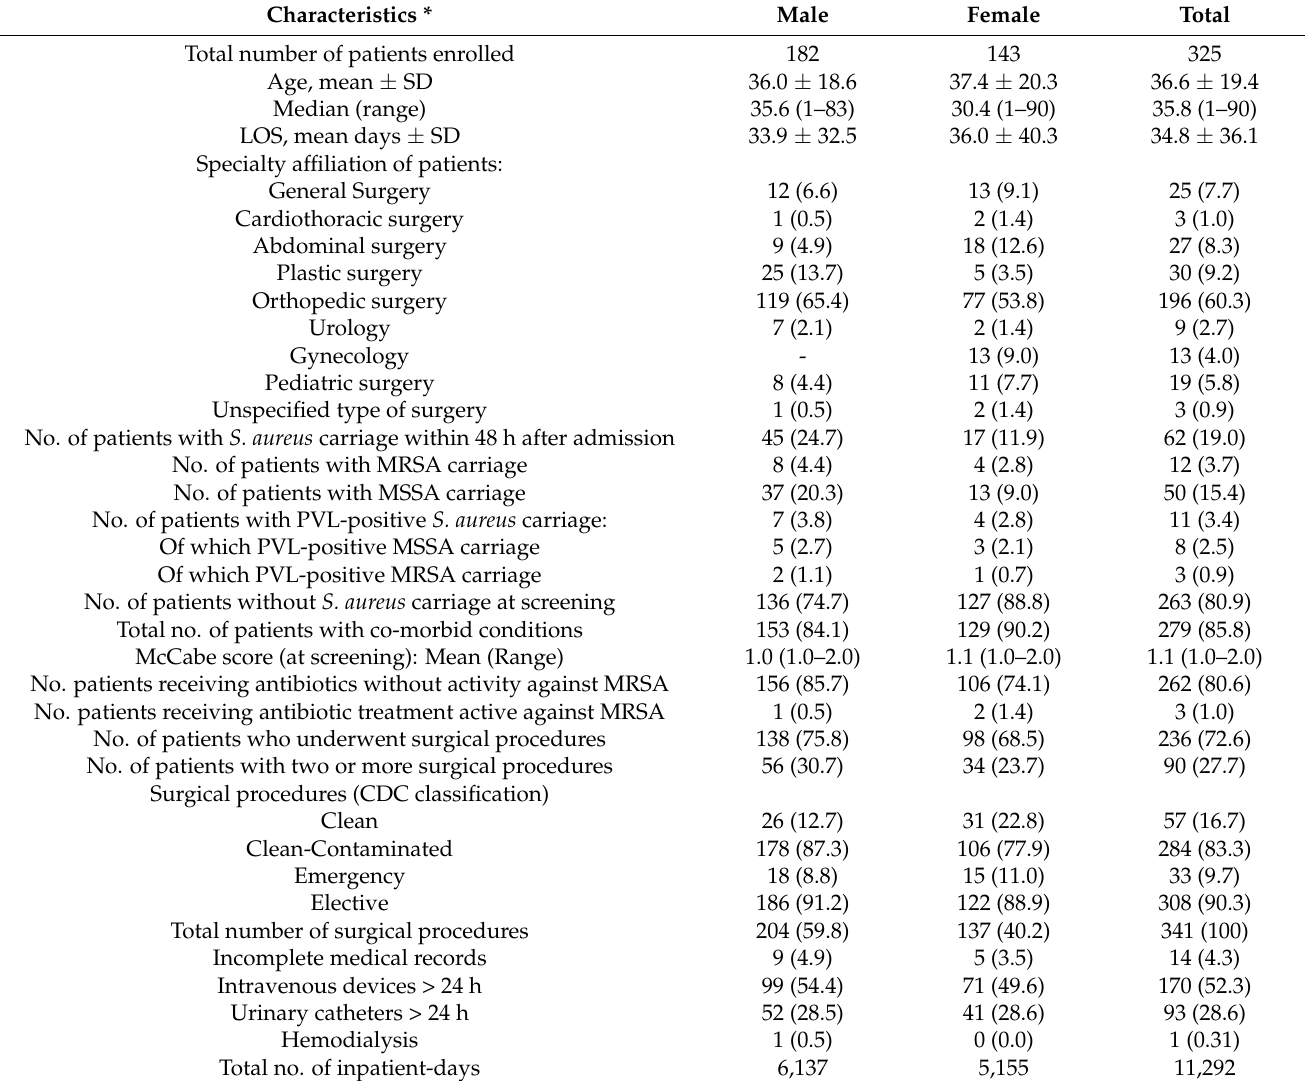
Table 1. Baseline characteristics of the surgical inpatient cohort ( n = 325).